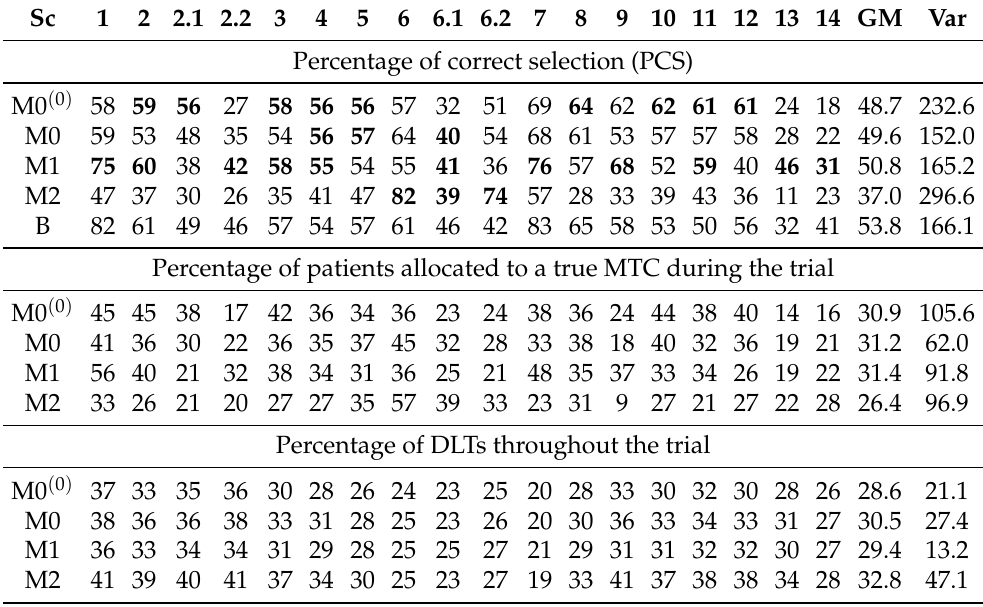
Table 4. Percentage of correct selection in comparison of 5 dose-finding designs and the benchmark (B) under Scenarios 1–14. Percentage of patients allocated to a true MTC during the trial and percentage of observed DLTs throughout the trial. GM is the geometric mean and Var is the variance. In the top third of the table, the highest PCS and those within less than 3% across the dose-finding designs are shown in bold for each scenario. Results are based on 4000